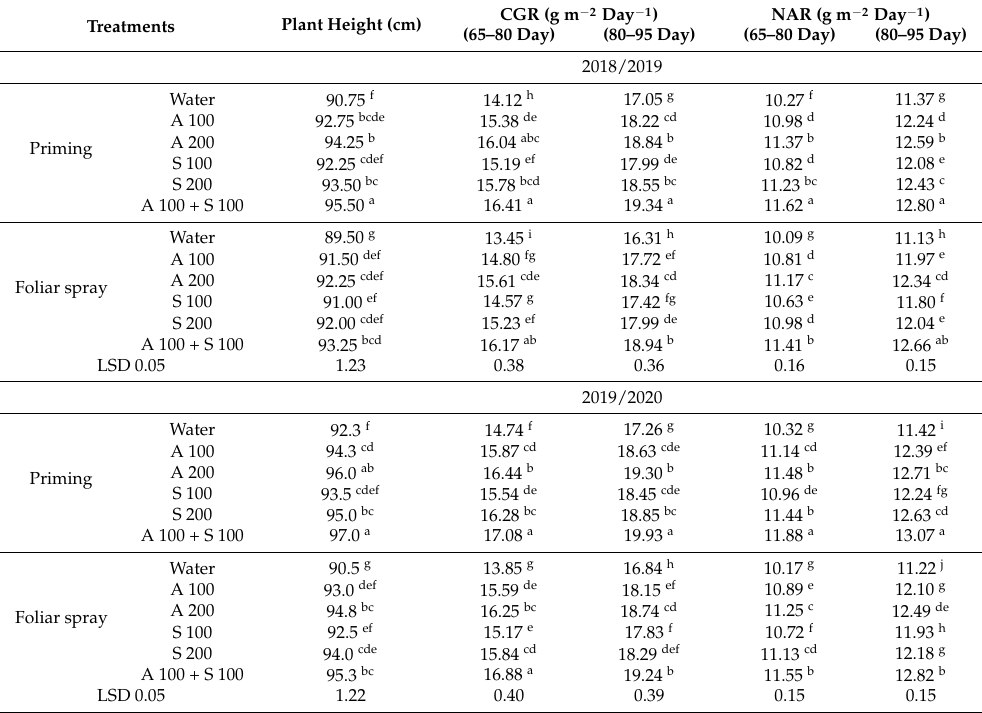
Table 3. Growth parameters (plant height, CGR, and NAR) of wheat plants treated with AA and SA as priming and foliar application at different concentrations in the two winter seasons 2018/2019 and 2019/2020.